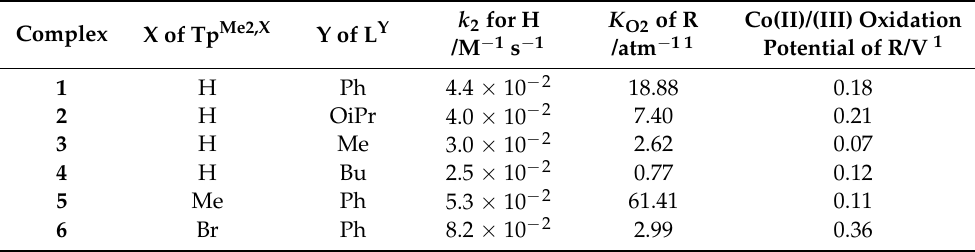
Table 3. The second-order formation rate constants ( k 2 ) for the hydroperoxido species 1 H – 6 H and related parameters of the cobalt(II) precursors 1 R – 6 R .